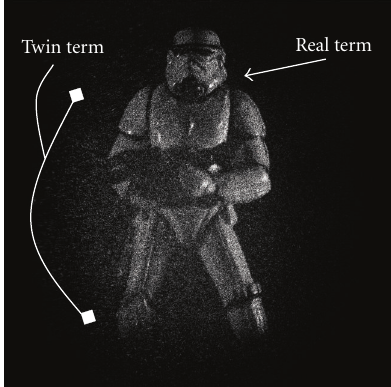
Figure 3: Same as Figure 2 however the DC terms have been removed using numerical processing